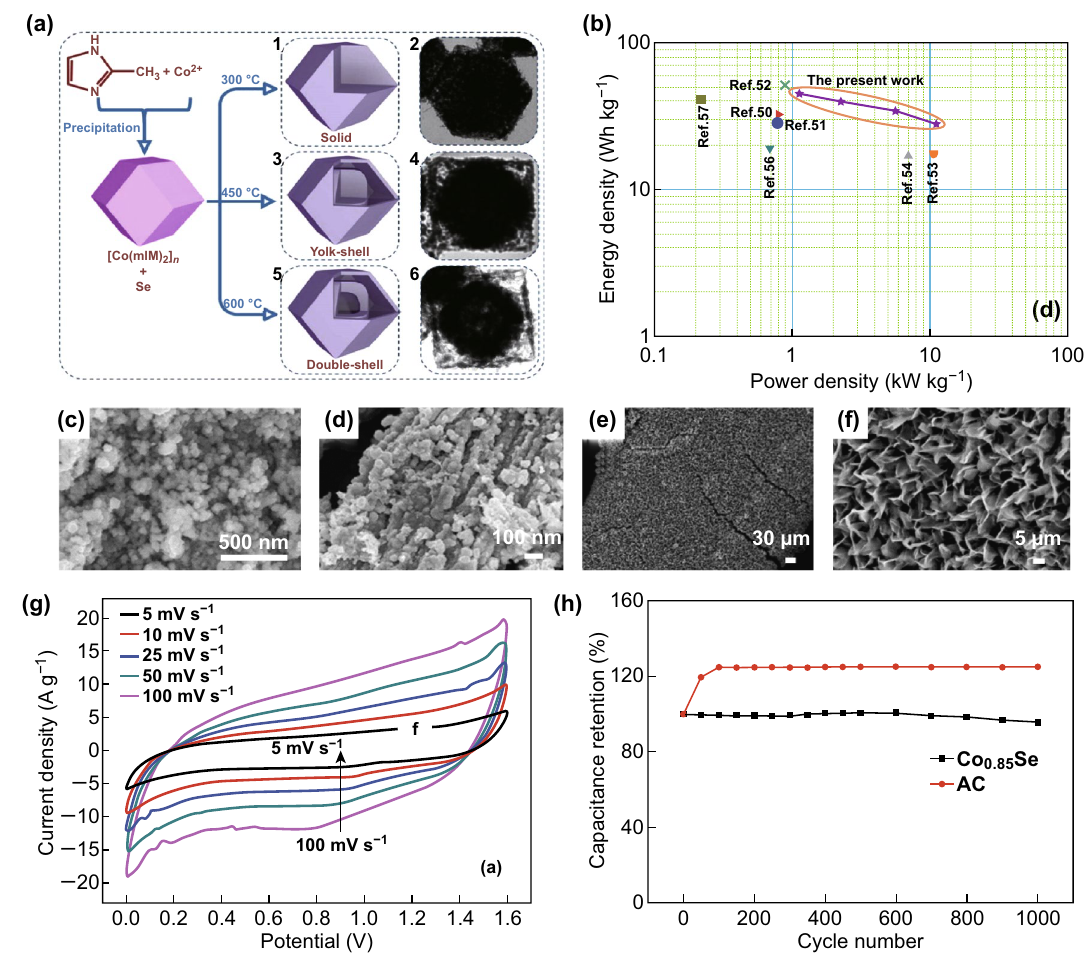
Fig. 9 a Solid preparation process diagram. b Ragone plots of an ASC device (energy density vs. power density). c FE-SEM image of CoSe nanoparticles. d FE-SEM image of a CoSe-G nanohybrid. e, f FE-SEM image of Co 0.85 Se nanosheets on Ni foam. g CV curve range of ASC at different scanning rates: 5–100 mv s −1 . h Electrochemical performance of Co 0.85 Se nanosheets, electrode cycling is 5 A g −1 . Adapted from